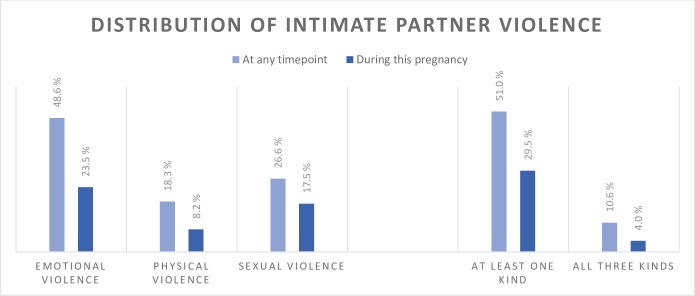
Distribution of intimate partner violence among women in the cohort.Total n = 1128.